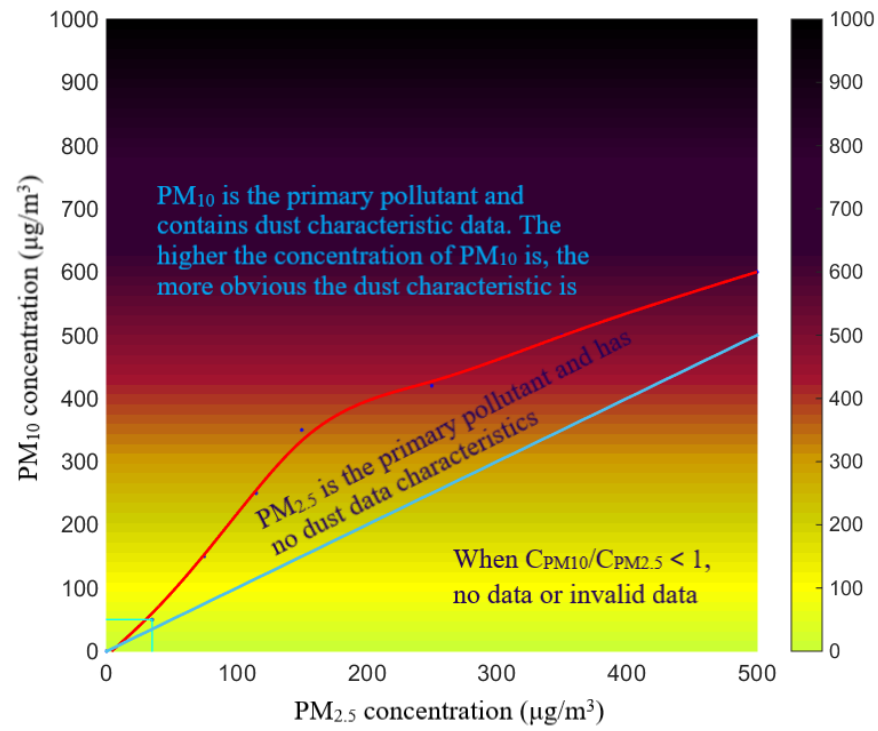
Figure 1. C PM10 /C PM2.5 features distribution (The dark blue dots represent the concentration thresh- olds of PM 10 and PM 2.5 , corresponding to IAQI from 0 to 500; The red curve is fitted from dark blue points to distinguish the characteristics of PM 10 or PM 2.5 as the primary pollutant; The light blue line indicates that PM 10 concentration equals PM 2.5 concentration).